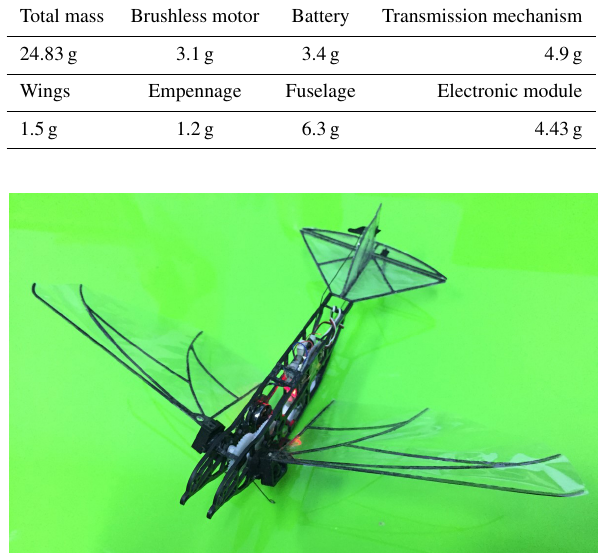
Figure 5. Photograph of assembled FWMAV of Type